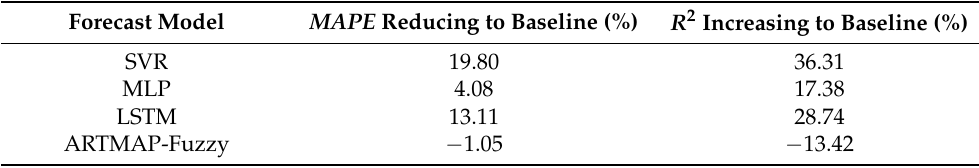
Table 14. MAPE and R 2 with a 30-min horizon using the implemented models compared to a persistent